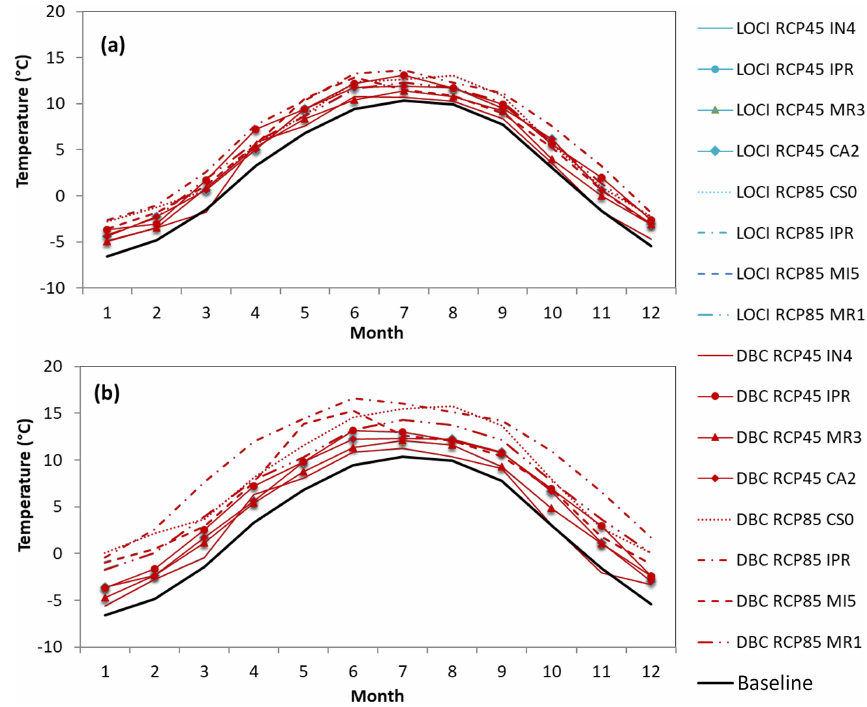
Figure 9. Monthly averages of observed temperature (1986–2005) and projected temperatures over the upper Beas basin during (a) 2046– 2065 and (b) 2080–2099. Projections are shown for two bias-correction methods (LOCI and DBC) with two ensembles of four GCMs under RCP4.5 and RCP8.5 (Table 2).